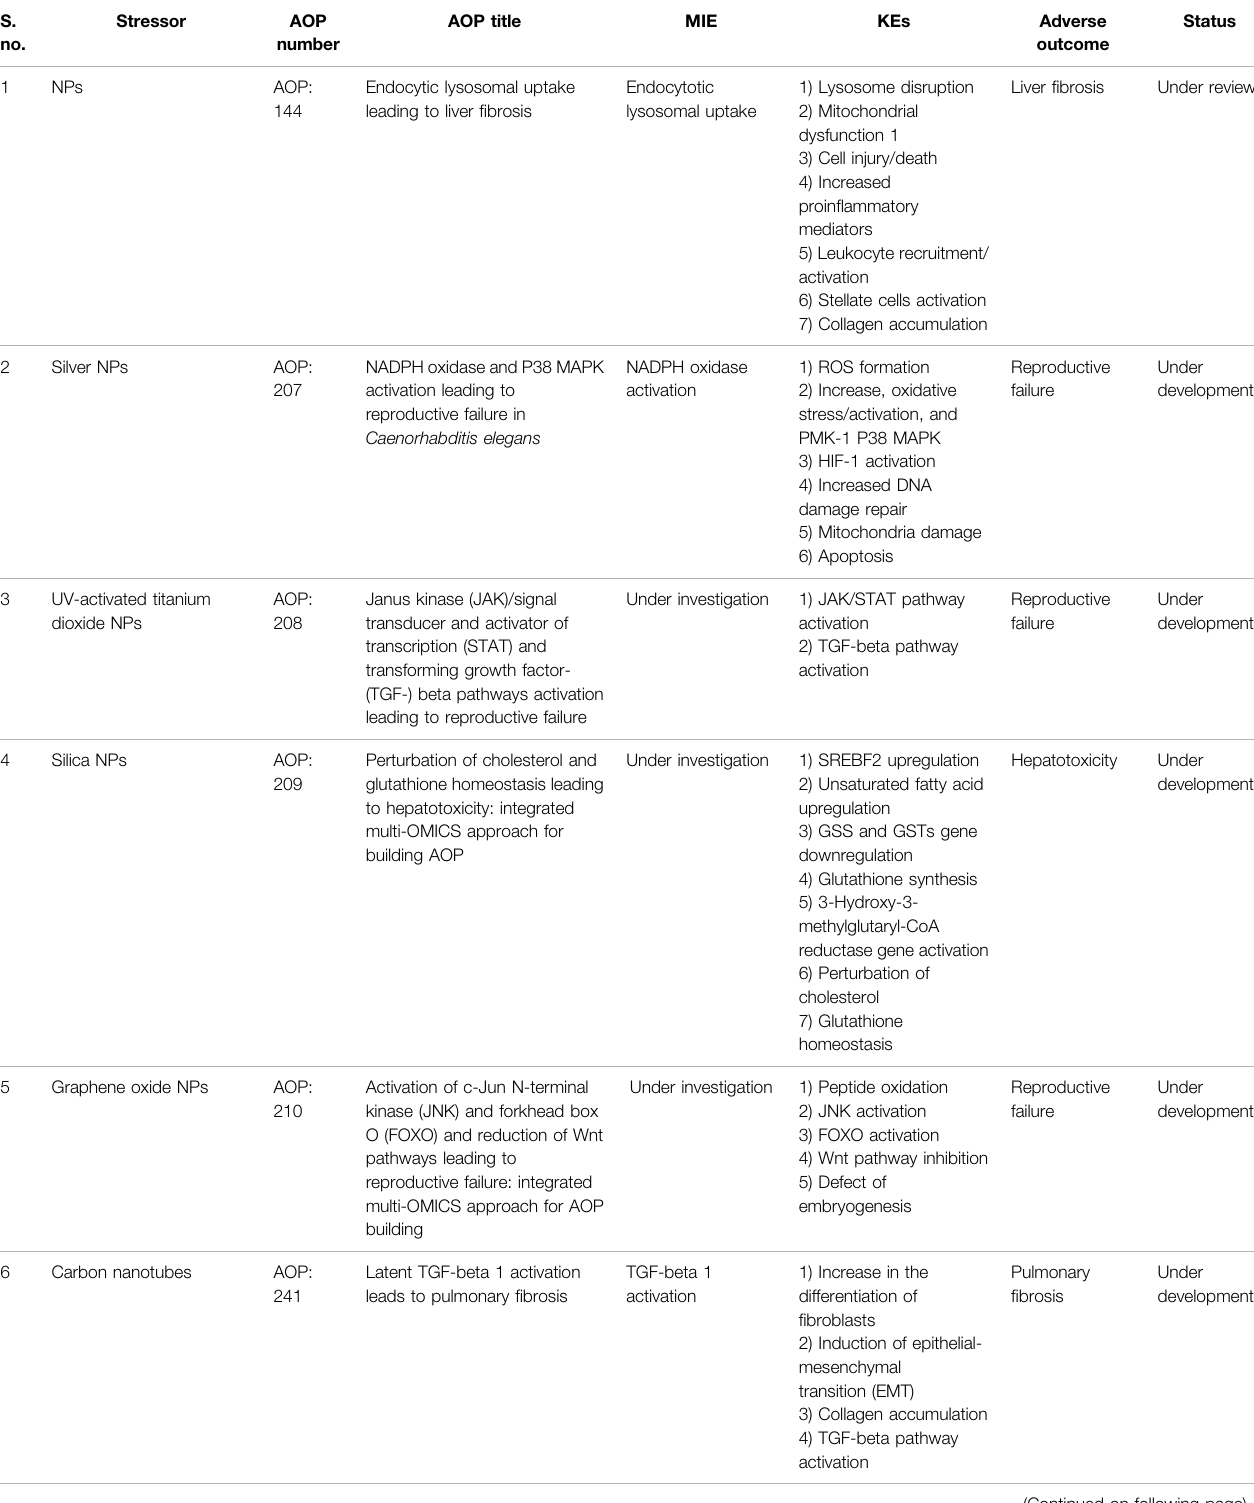
TABLE 3 | List of AOPs which are currently in various stages of development focused on NPs S.